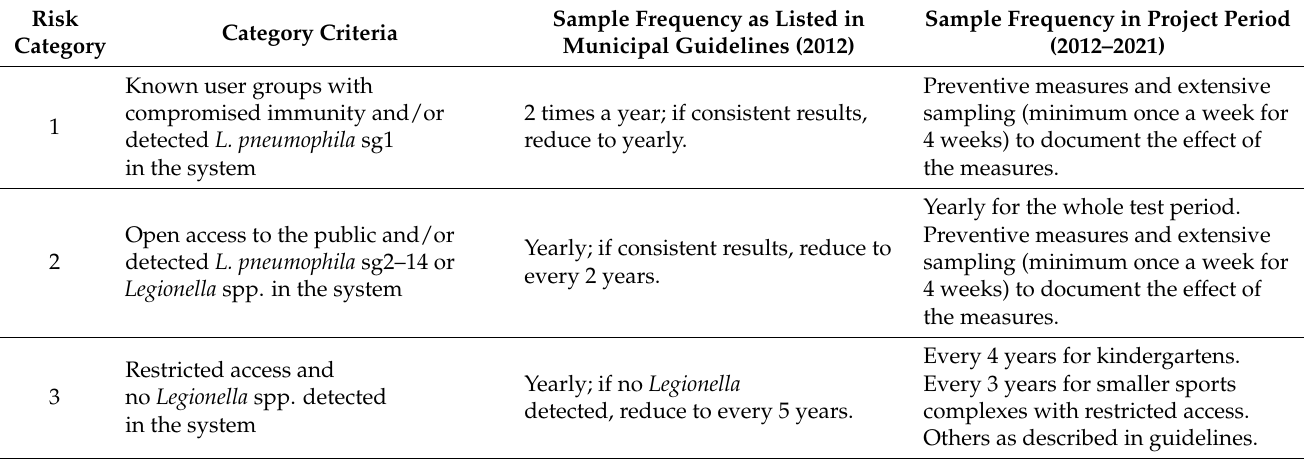
Table 1. Risk categories, criteria and sample frequencies according to the internal guidelines of Stavanger municipality.